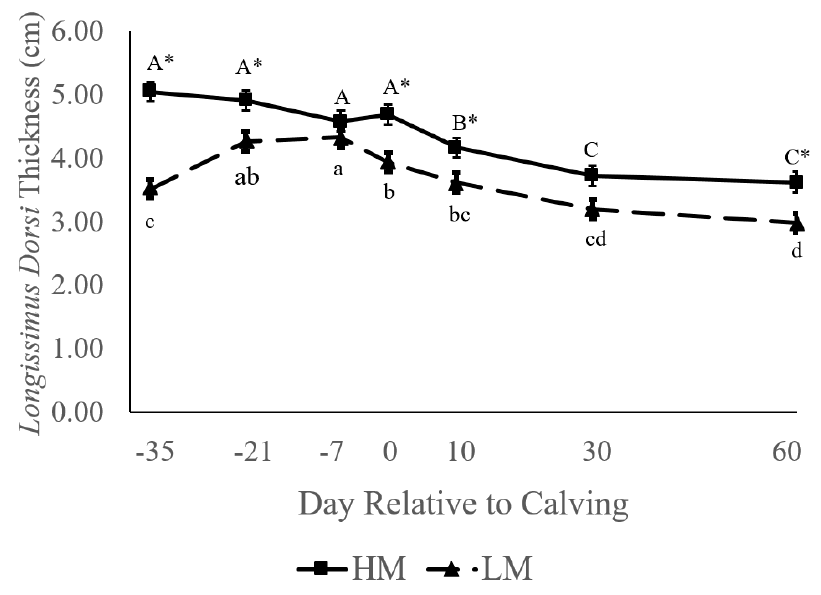
Figure 1. Longissimus dorsi thickness (LDT) between high-muscle (HM; n = 20) and low-muscle (LM; n = 21) cows at different time points, from 35 d before expected calving (BEC) to 60 d in milk (DIM). Cows were assigned to a group based on LDT at 35 d BEC. HM LDT was >4.49 cm and LM LDT was ≤ 4.37 cm at 35 d BEC. Differences in uppercase letters indicate a difference between time points within HM; lowercase letters indicate a difference between days within LM; and an asterisk indicates a difference between groups within a day at p < 0.05.